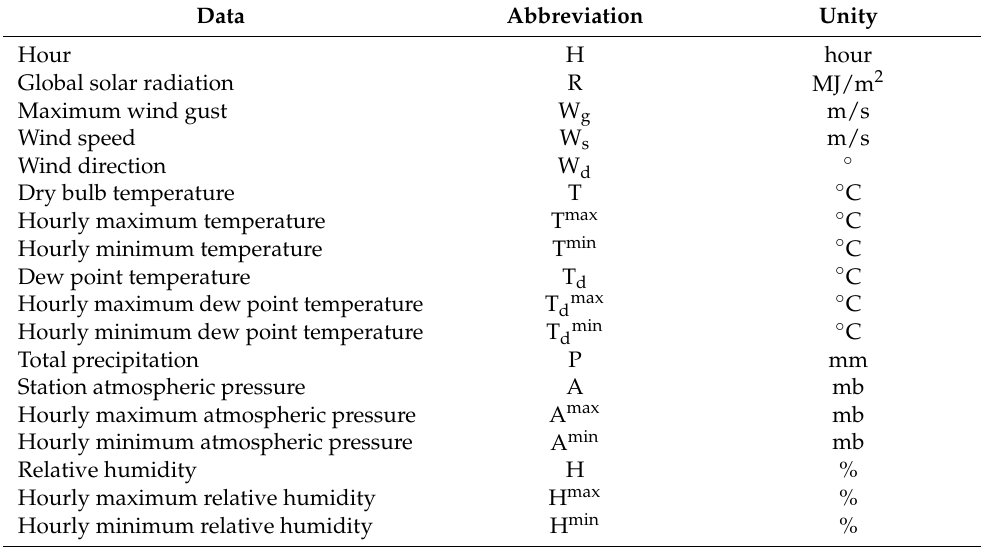
Table 1. Available database for solar radiation forecasting.